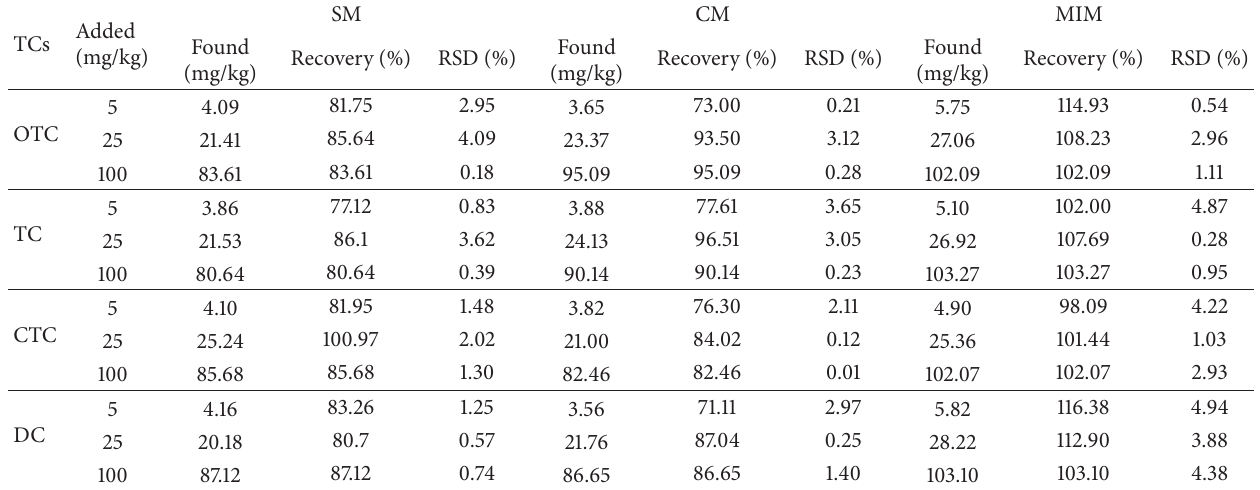
Table 5: The related recoveries of TCs in fertilizer samples by proposed